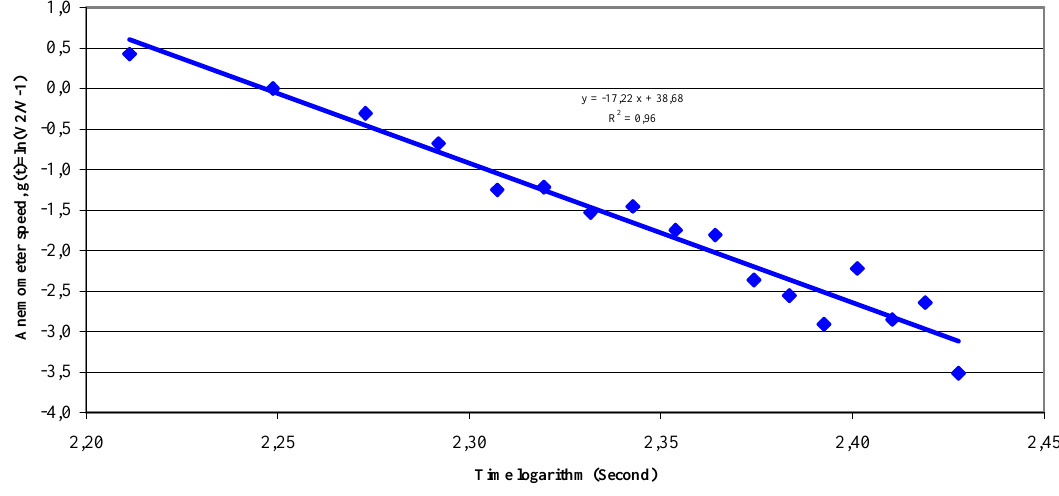
Figure 2 Fig. 2. Anemometer speed function f(t)=V 2 /V-1 versus the time, in logarithmic axes with linear regression (Anemometer 25-2).